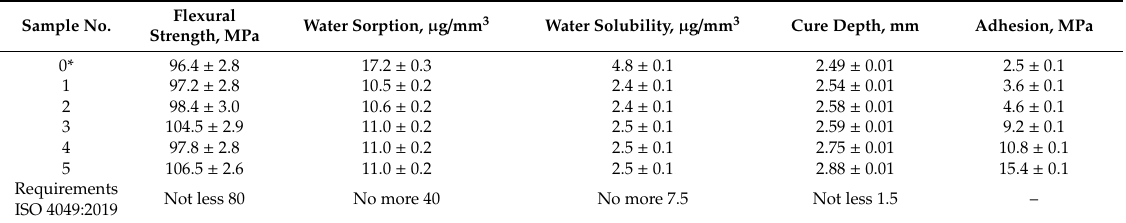
Table 2. Requirements ISO 4049:2019 for the restorative dental materials and results of the tests for the cured dental compositions. Adhesion was measured according to ISO 4049:2009.